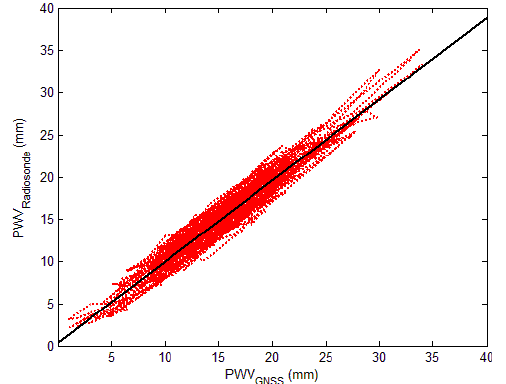
Figure 4. Correlation of GNSS-estimated PWV and radiosonde results at DIYB station